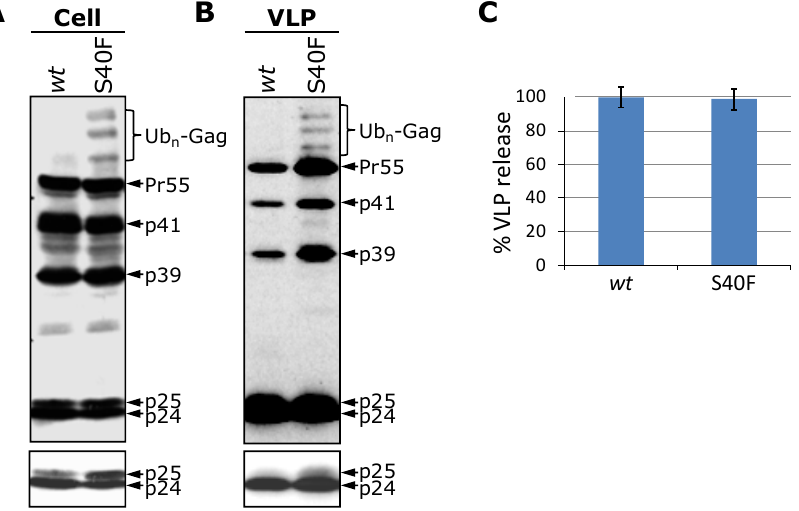
Figure 1. The S40F mutation in p6 augments Gag ubiquitination. HeLa cells were transfected with the env -deleted HIV-1 expression plasmid pNLenv1, as wt or